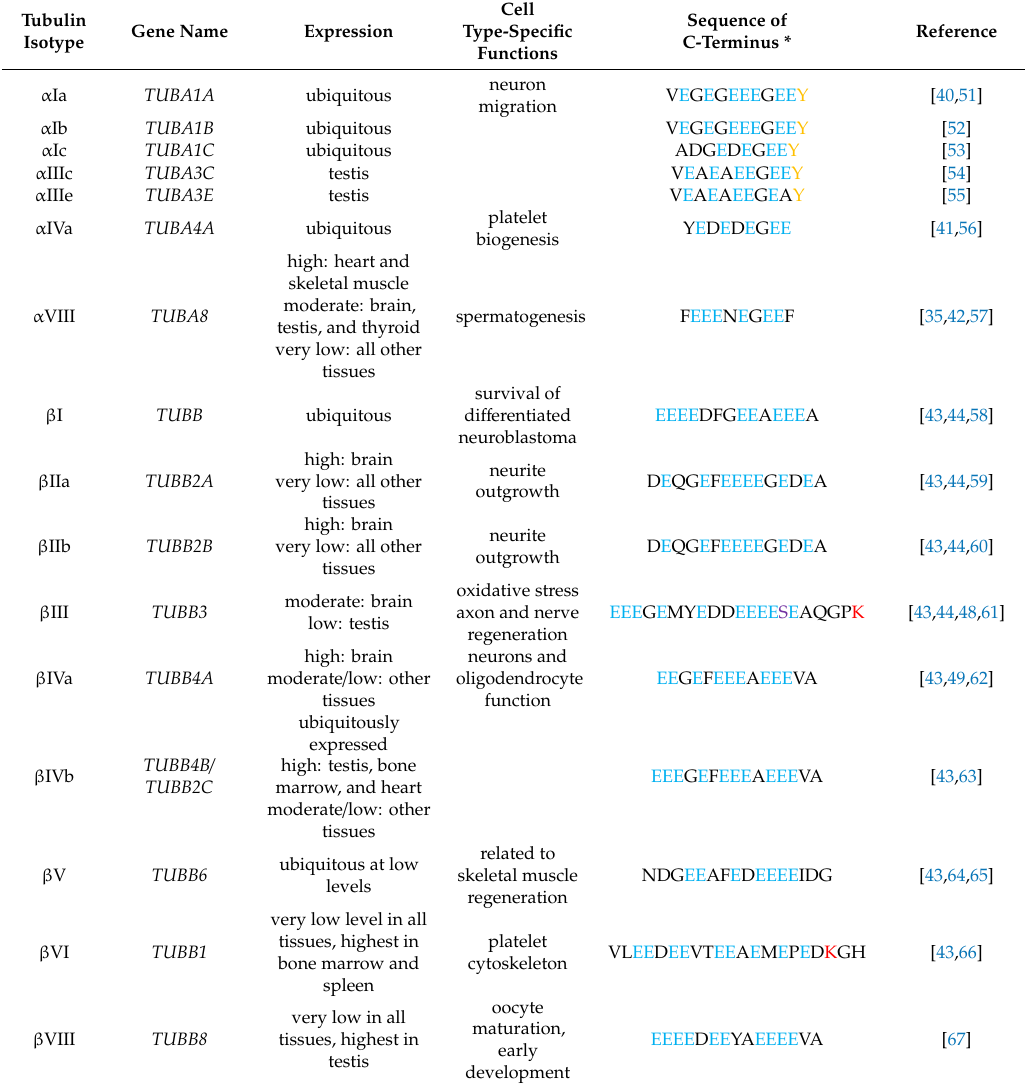
Table 1. Features of human tubulin